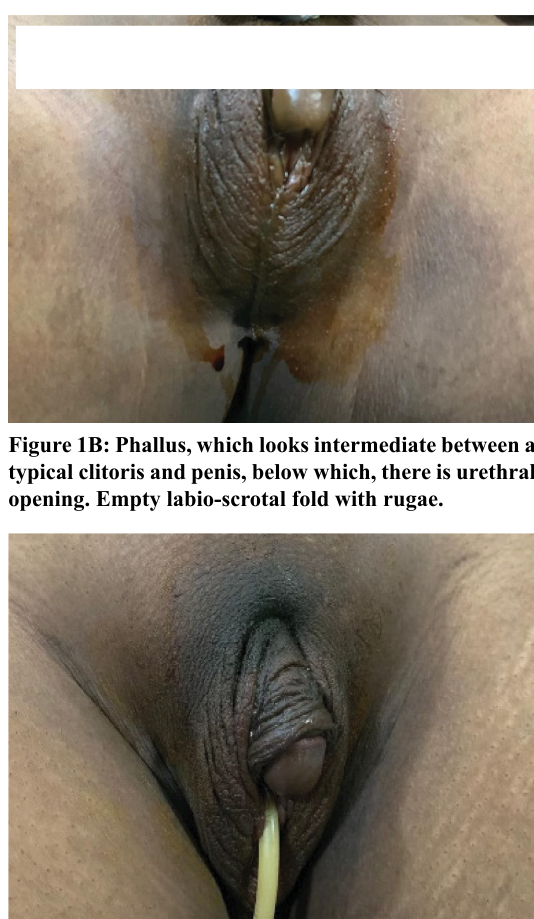
Figure 1A: Breast Examination showing Gynecomastia. ( Permission for publication was obtained)